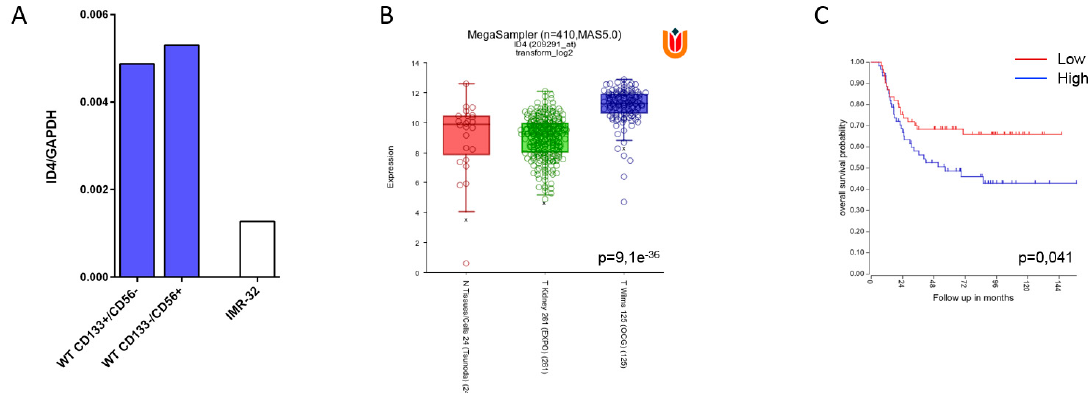
Figure 6. ( A ) ID4 expression measured by qRT-PCR in two Wilm’s tumor primary co-cultures with CD133 + /CD56 − or CD133 − /CD133 + phenotype. ID4 expression in the human neuroblastoma cell line IMR-32, which does not exhibit immunosuppressive effects on NK cells, is also shown. Data are expressed as 2- ∆ Ct with respect to GAPDH expression, used as endogenous control. ( B ) Gene expression analysis performed on R2 public dataset comparing the expression of ID4 between normal tissues (control, in red), kidney tumors (green) and Wilm’s tumors (blue). ( C ) Overall survival of patients with Wilm’s tumors included in the OCG study based on the expression of ID4. The analysis was performed on R2 public dataset using median as cutoff (124 patients, 62 low, and 62